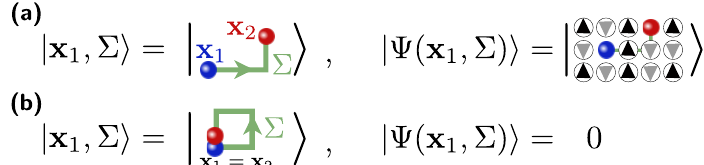
Figure 1: We work in an effective Hilbertspace consisting of pairs of dopants (red and blue) connected by a string Σ on a square lattice. Every state | x occupancies of any site with two dopants is associated with a unique state | Ψ ( x in the microscopic model. (a) A typical example with string length ℓ Σ = 3. (b) Rare loop configurations leading to double-occupancies of dopants have no corre- spondence in the microscopic